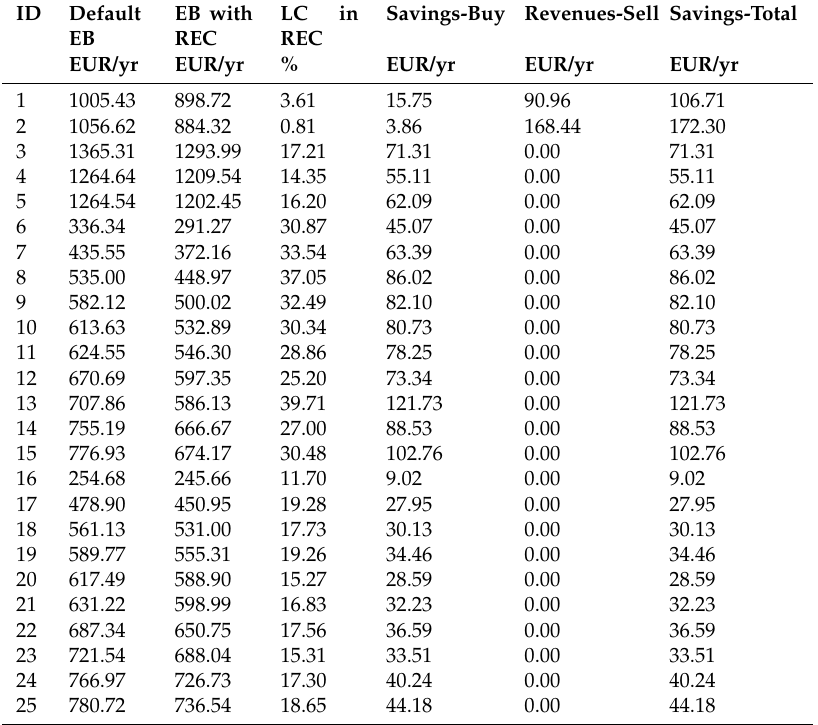
Table 6. Purely residential REC: Results for customers 1–25. Detailed explanation of the individual columns given in Table 5. Note, that revenues due to selling electricity within the community are zero for MAB residents 6–15 despite the availability of an in-house PV system, because the PV system is externally-owned.